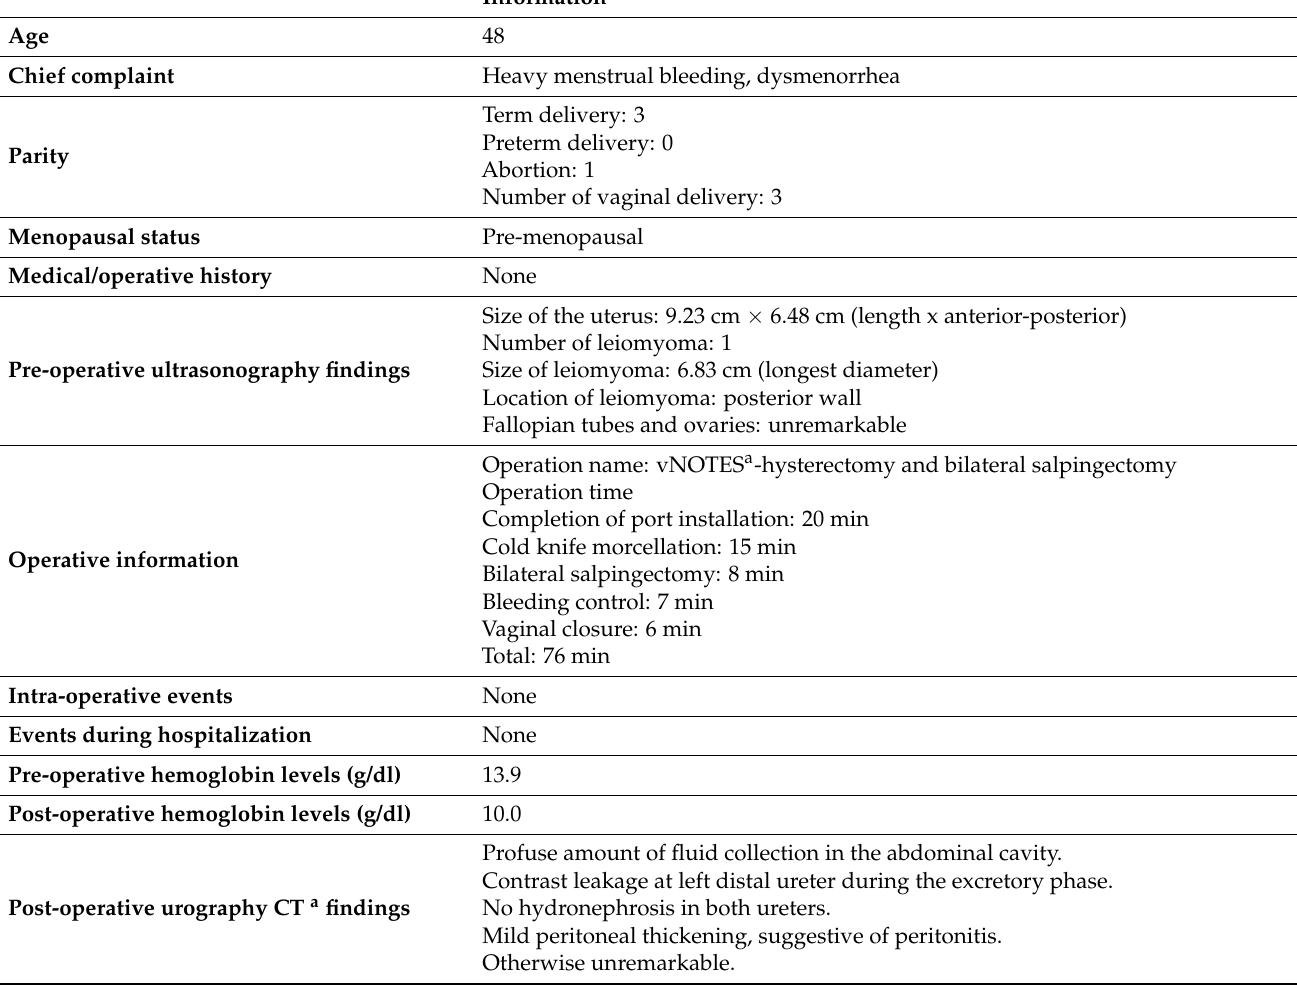
( B ) Figure 3. Image of the right ureter during vNOTES hysterectomy ( A ) when the uterus was still at- tached and ( B ) when the uterus was completely removed. The benefits of vNOTES may be maximized in specific patient populations. The wider shape of the pelvis in Western populations compared to Asian populations may allow for an easier surgical approach by surgeons through the vagina. The benefits of re- duced port site herniation rates by approaching through the vagina instead of the umbil- icus may also be expected in Western populations, who generally have a higher BMI com- pared to Asian populations. A high BMI is an important risk factor for postoperative port- site herniation. vNOTES and SPA laparoscopic surgery both come with benefits and risks. In the present study, a single experienced surgeon thoroughly examined each patient preopera- tively to determine the best surgical approach. Patients with a narrower pelvic space or who were expected to have adhesion in the intra-abdominal cavity were more likely to undergo SPA laparoscopy than those who underwent vNOTES. The criteria for adequate candidates for vNOTES were stricter than those for SPA laparoscopic surgery. Choosing between the two surgical methods based on preoperative examinations is a critical step and requires abundant experience from surgeons. Simultaneously, the fact that the sur- geon of the present study decided which surgical approach to take for each patient may limit the generalizability of the results of this study. Patients who received vNOTES had more movable and non-adhered pelvic organs; therefore, they were generally easier to treat surgically compared to those who underwent SPA laparoscopic surgery. There is a